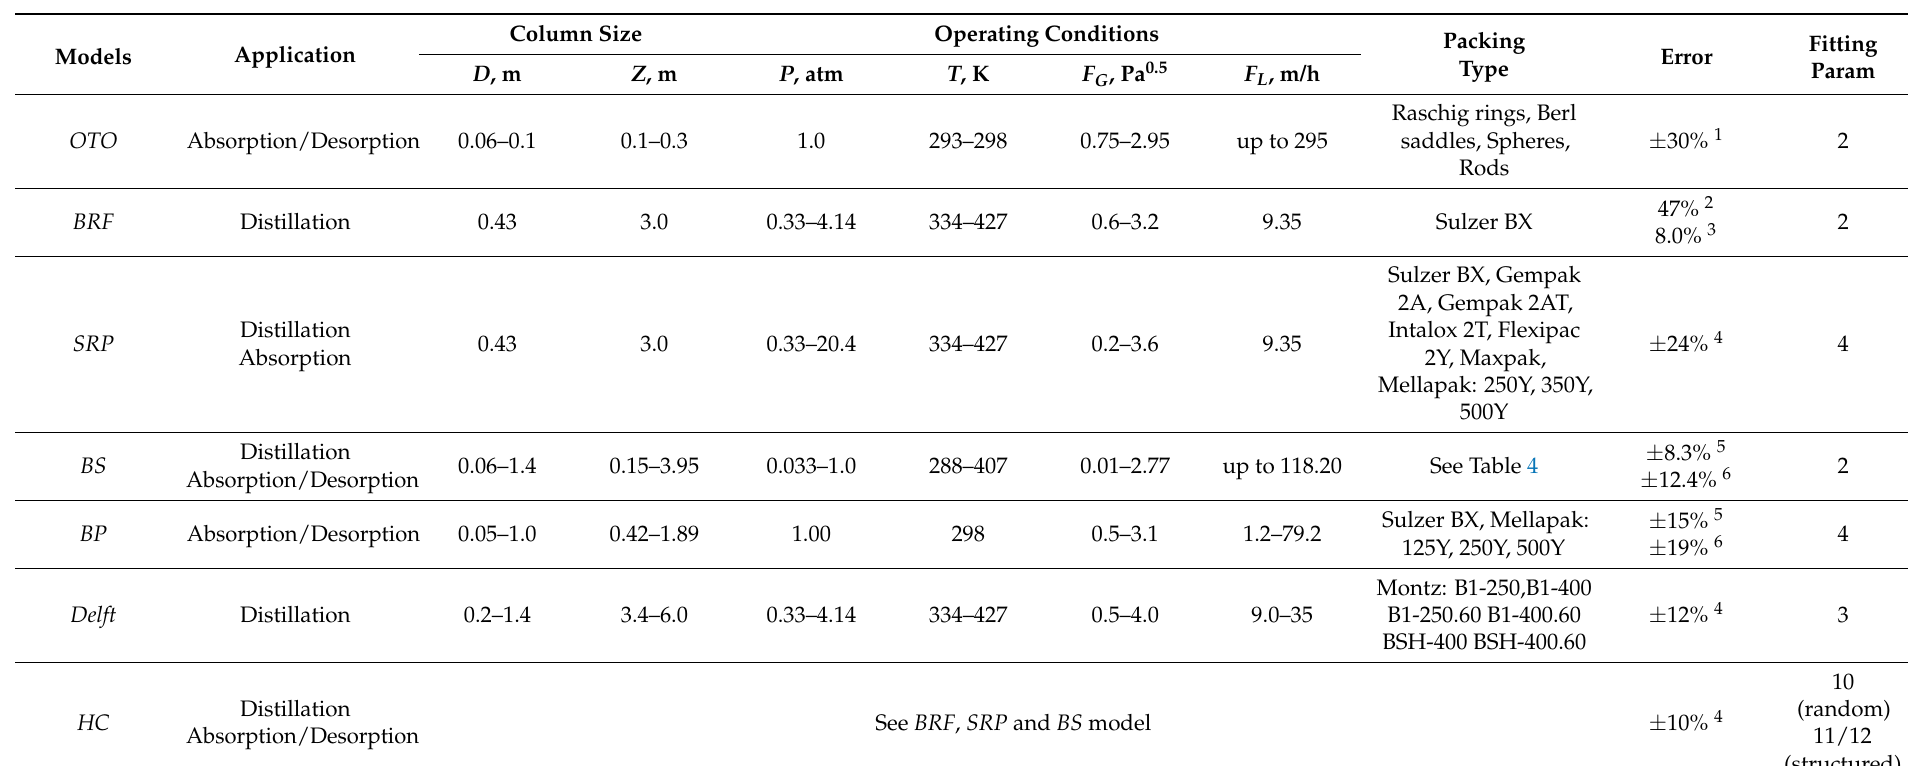
Table 9. Summary of the validity and applicability ranges of the correlations examined in this Section, based on packing/application, experimental conditions, number of fitting parameters and estimated error adopted by the authors for their